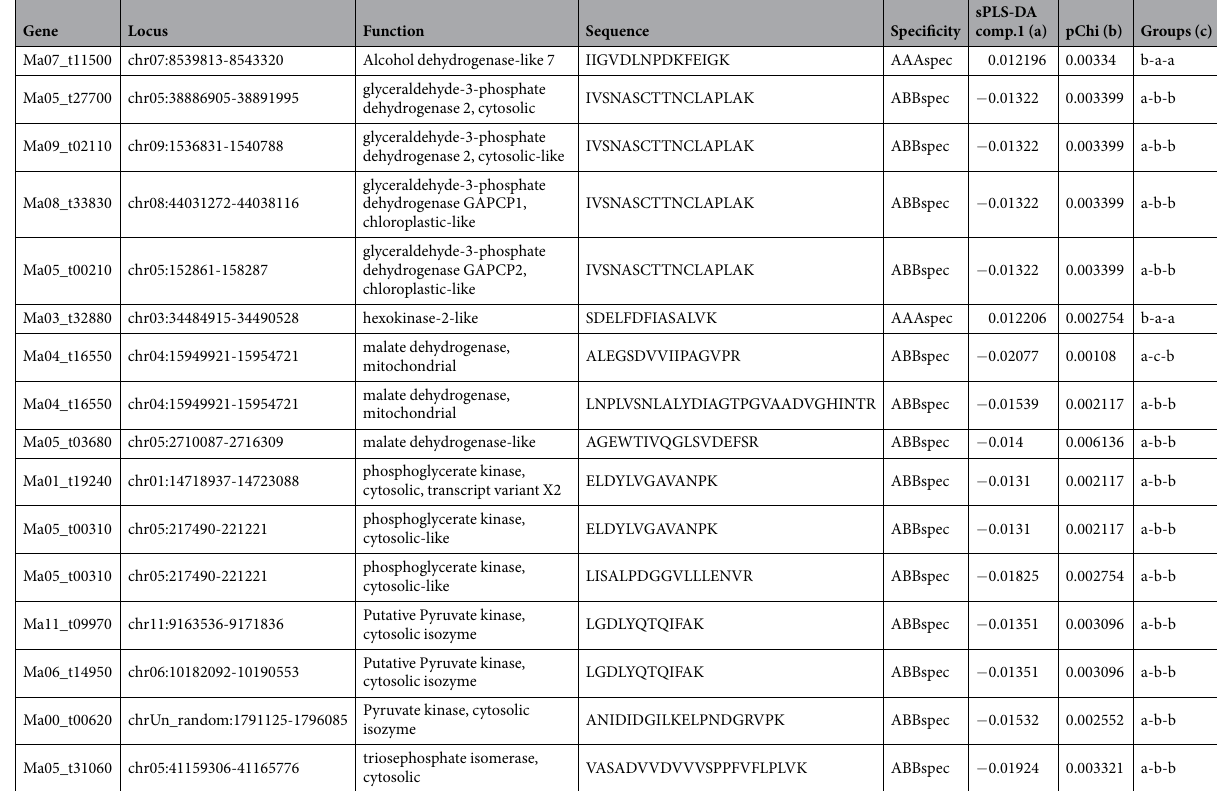
Table 2. Selection of mass identical proteome features with cultivar specific abundance. Example data for proteins involved in glycolytic processes are shown. Feature selection is based on sparse partial least squares discriminant analysis (sPLS-DA) component 1 (a), Kruskal Wallis p-value (b), indicated by groups (Cachaco - Grande Naine-Mbwazirume) (c), a > b >